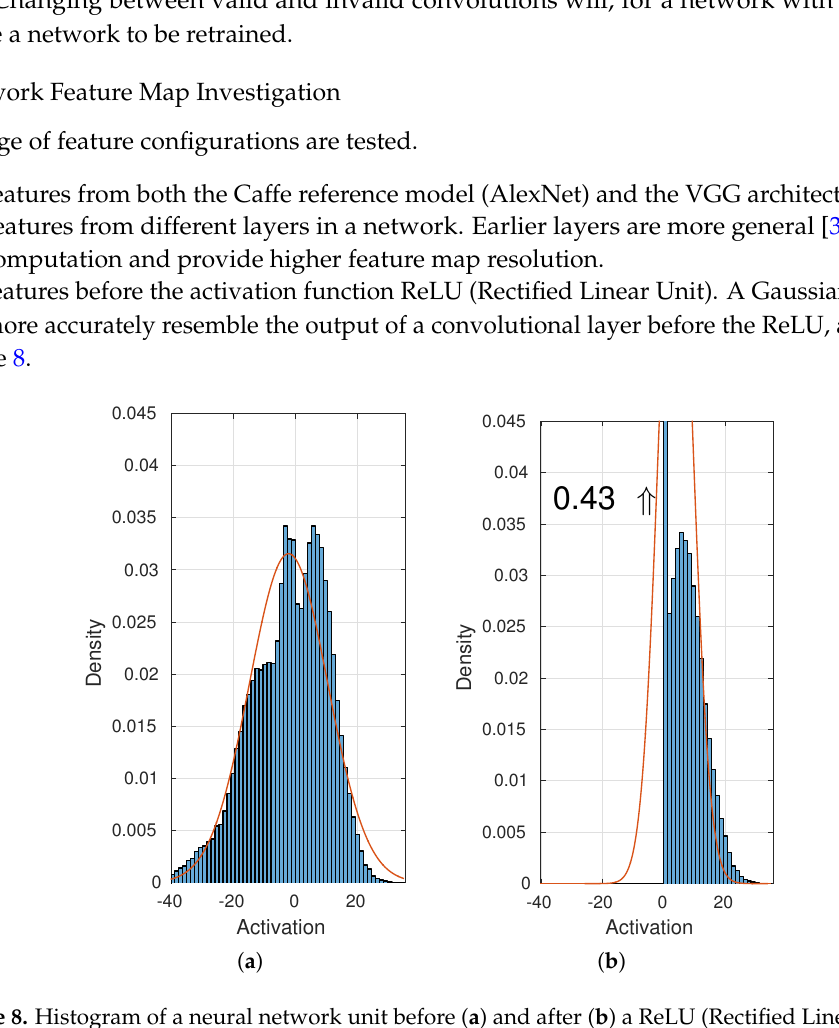
Figure 8. Histogram of a neural network unit before ( a ) and after ( b ) a ReLU (Rectified Linear Unit).